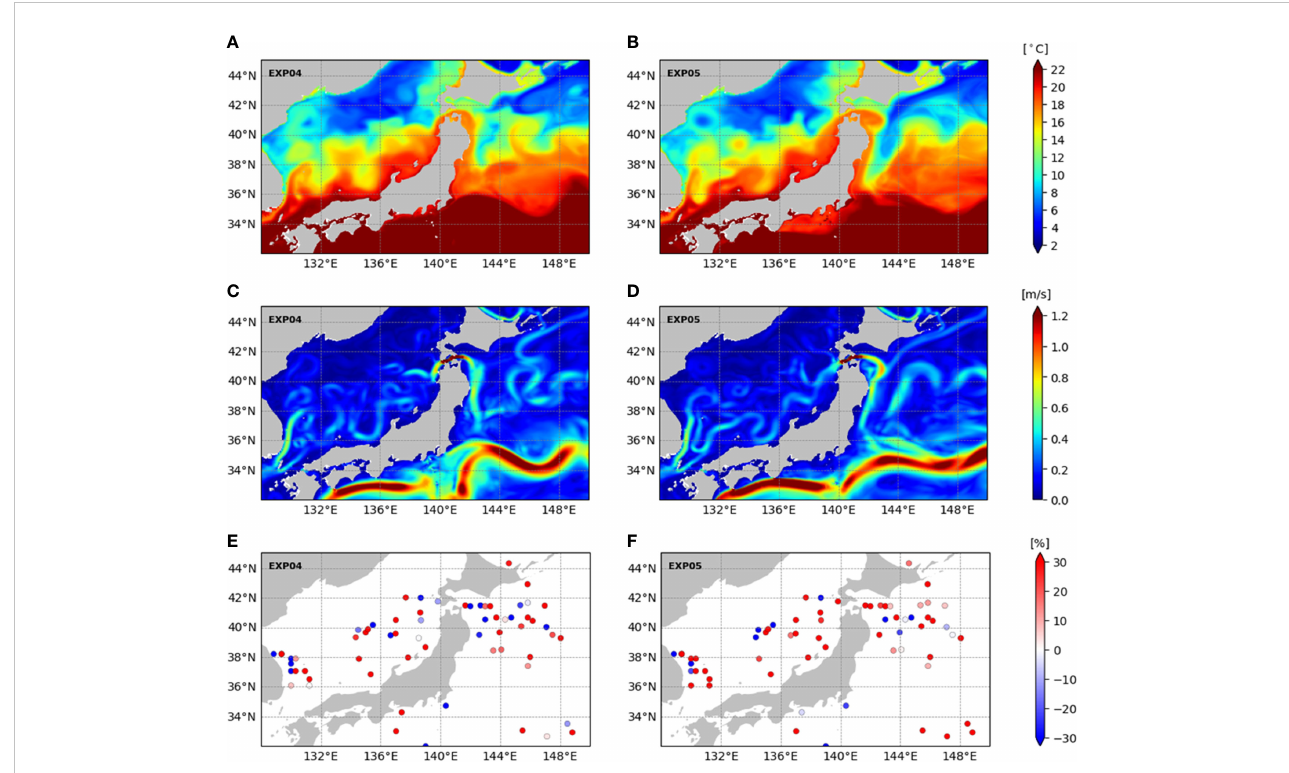
FIGURE 10 Monthly mean temperature (upper panels), current speed (middle panels) averaged over 0 to 100m, and IOA (lower panels) for the temperature pro fi les over 0 to 100m in EXP04 (left panels) and EXP05 (right panels) in